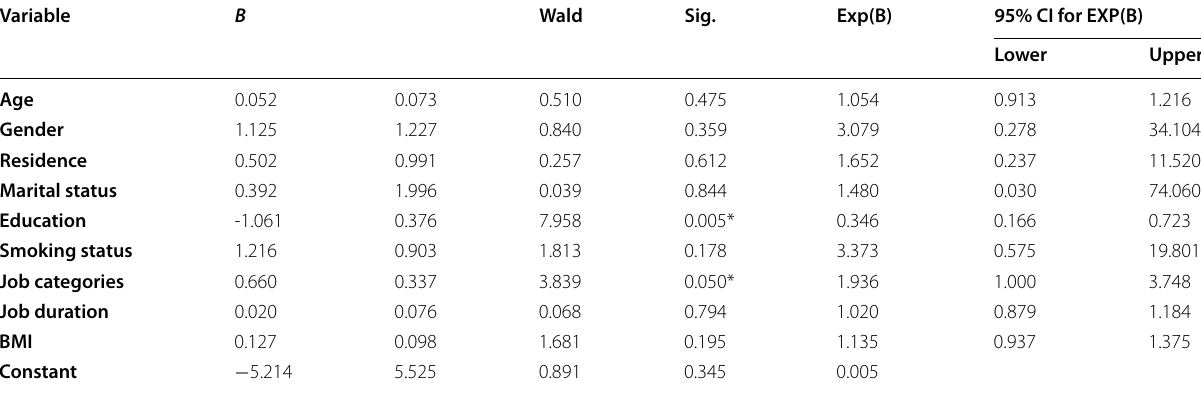
* Statistically significant at P